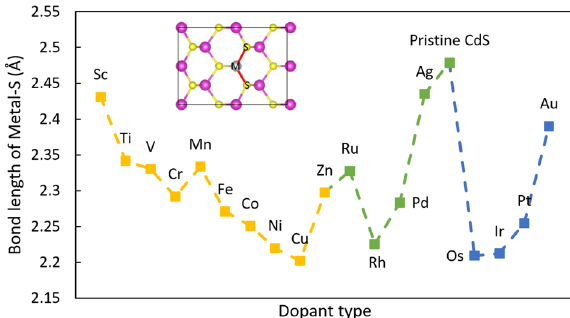
Fig. 1 Screening protocol for the discovery of transition metal- doped CdS catalysts. The followed process includes (1) examination of the structural stability ofdifferent TM@CdS surfaces based on their corresponding binding energies (E b ), cohesive energies (E c ), and formation energies (E f ); (2) the band gap and d-band center to estimate the optical and electronic properties; (3) the change in the Gibbs free energy ( Δ G) of the adsorbates. The right panel shows a schematic representation of theTM-doped CdS (110) catalyst.